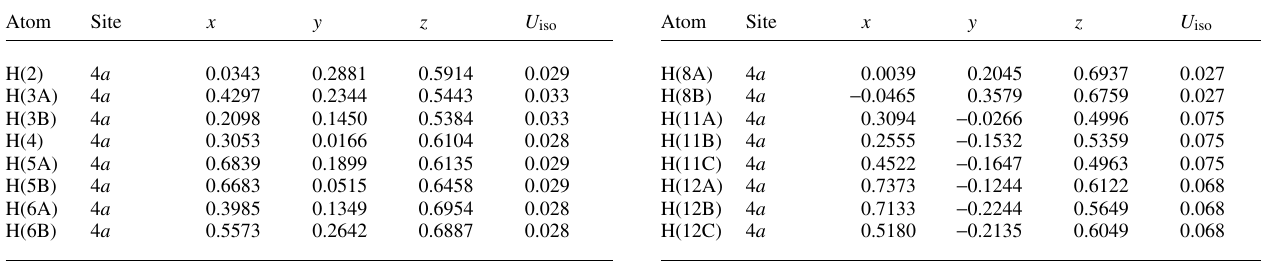
Table 3. Atomic coordinates and displacement parameters (in Å 2 ) .